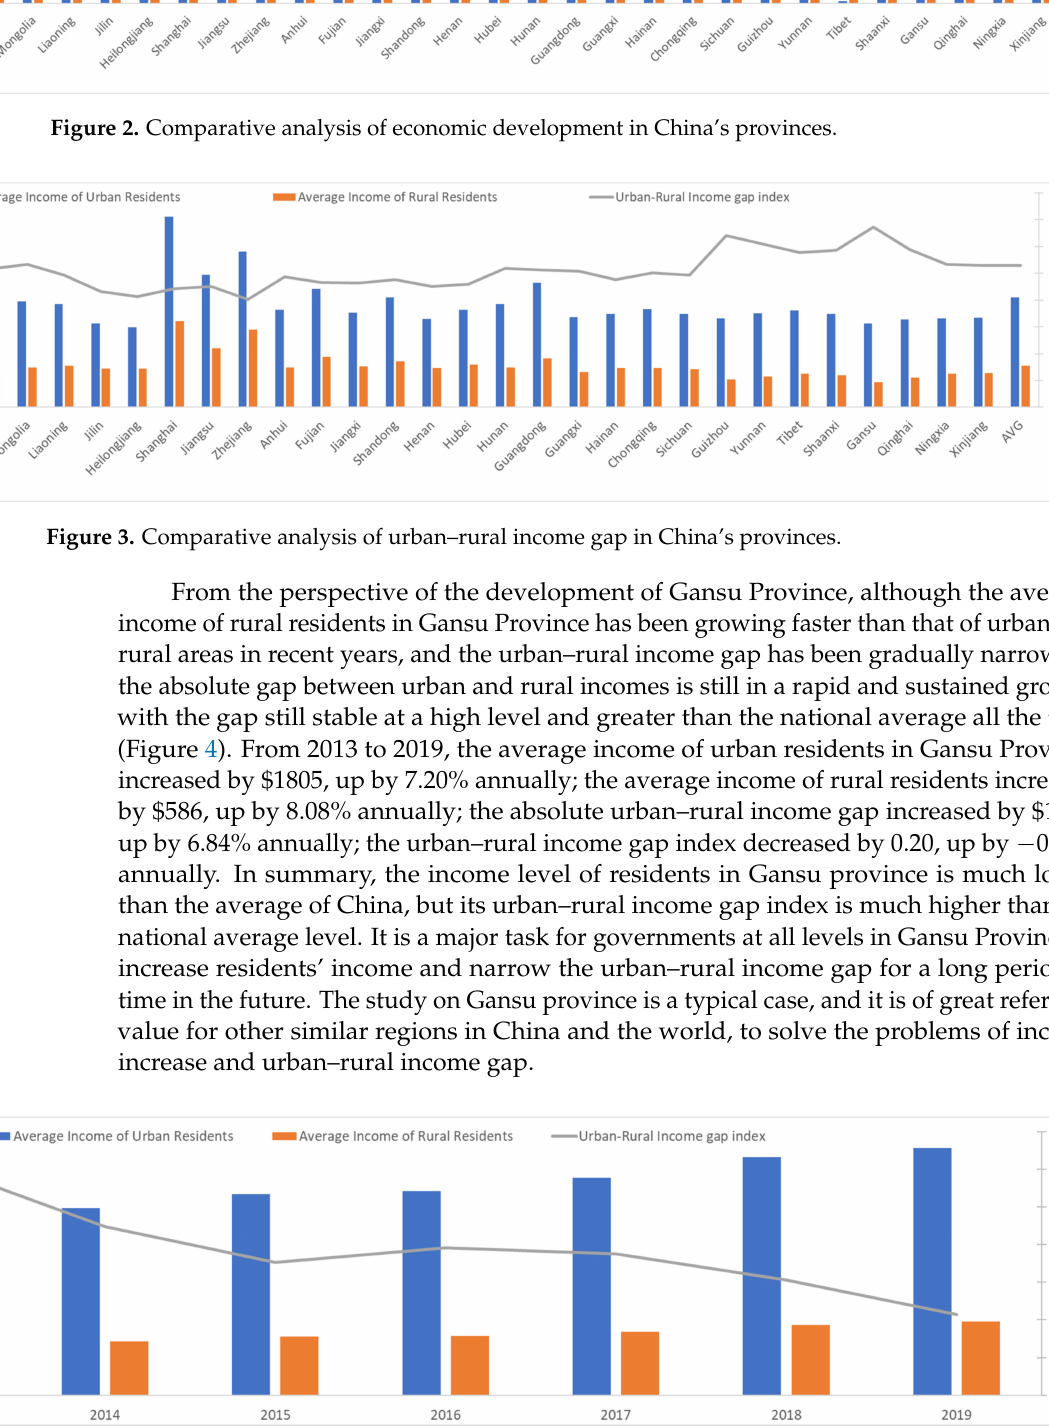
Figure 4. Analysis on the change of urban–rural income gap in Gansu